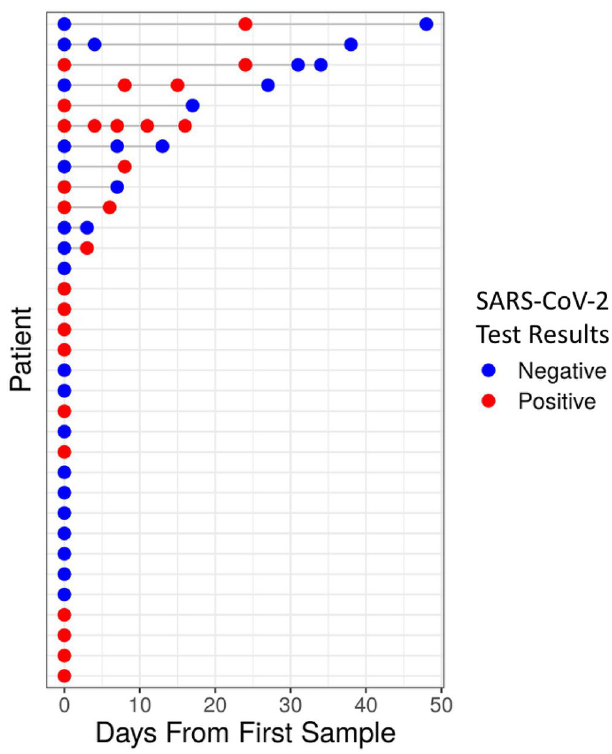
Figure 1. Longitudinal cohort of 55 samples from 33 subjects confirmed or suspected as being SARS-CoV-2 positive. Each row corresponds to an enrolled subject, over the number of days since first sample included in this study. Colors represent SARS-CoV-2 test results for a specific sample, with red and blue indicating SARS- Cov-2 positive and negative samples respectively.